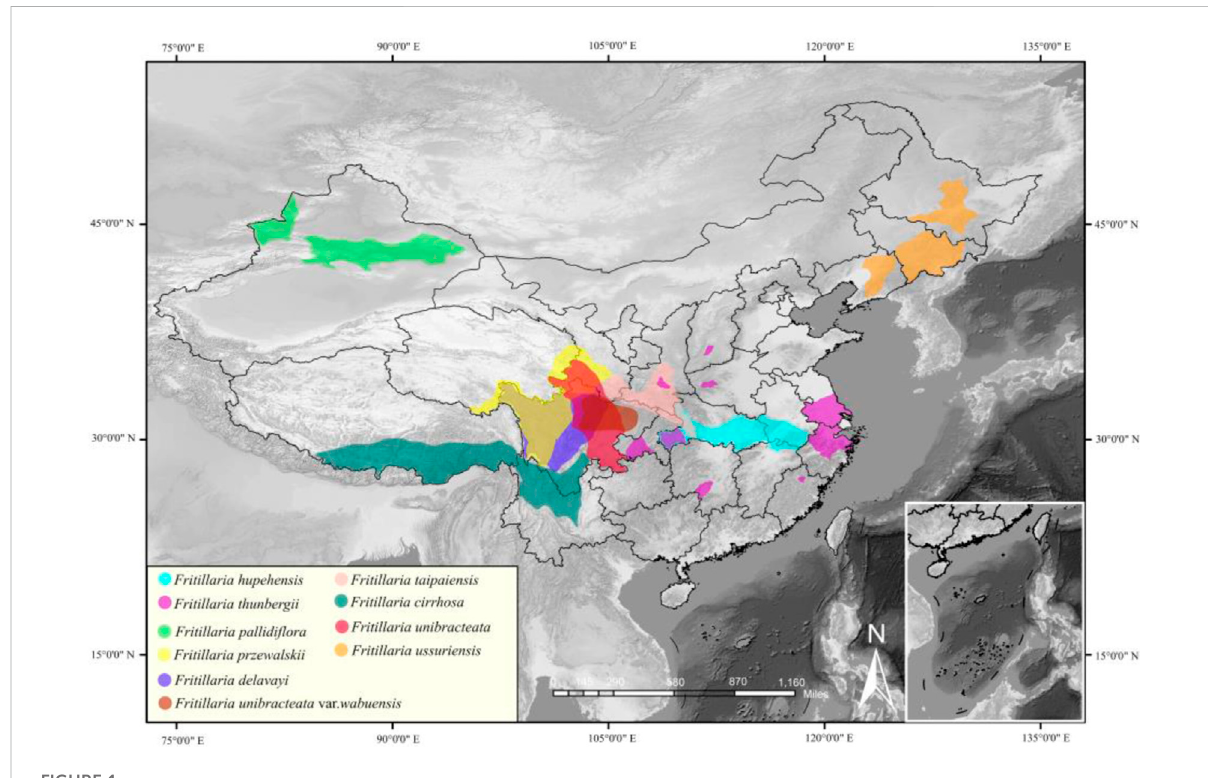
FIGURE 1 Common medicinal plants of the genus Fritillaria L. in